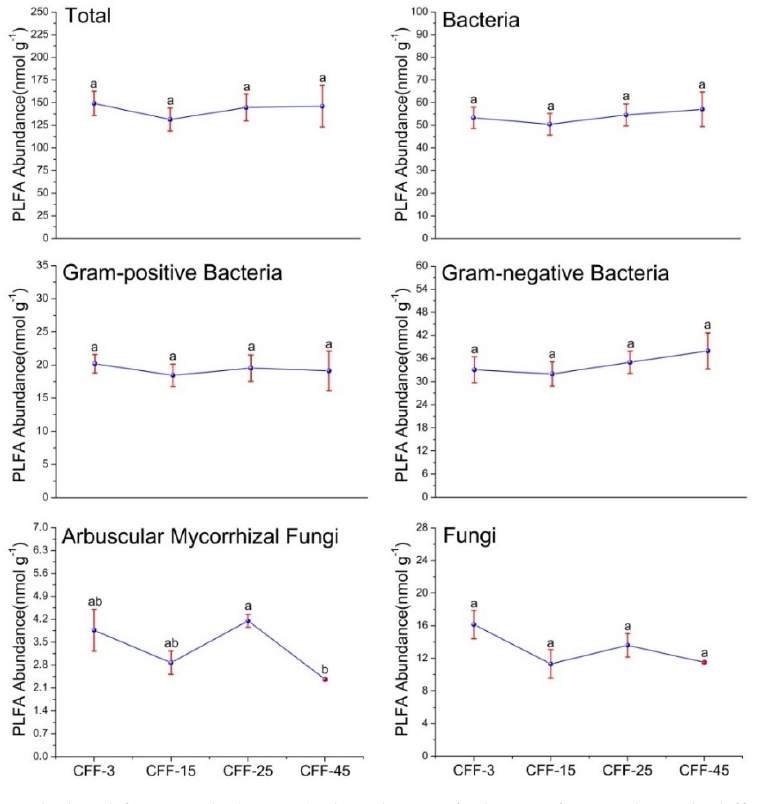
Figure 2. Phospholipid fatty acids (PLFAs) abundance of Chinese fir stands with different ages in Jiangxi Province. Values are means ( n = 3) with a bidirectional stand error bar. Via Duncan’s multiple comparison test, different letters in the same columns indicate significant difference among ages. CFF-3, 3-year Chinese fir forests; CFF-15, 15-year Chinese fir forests; CFF-25, 25-year Chinese fir forests; CFF-45, 45-year Chinese fir forests.